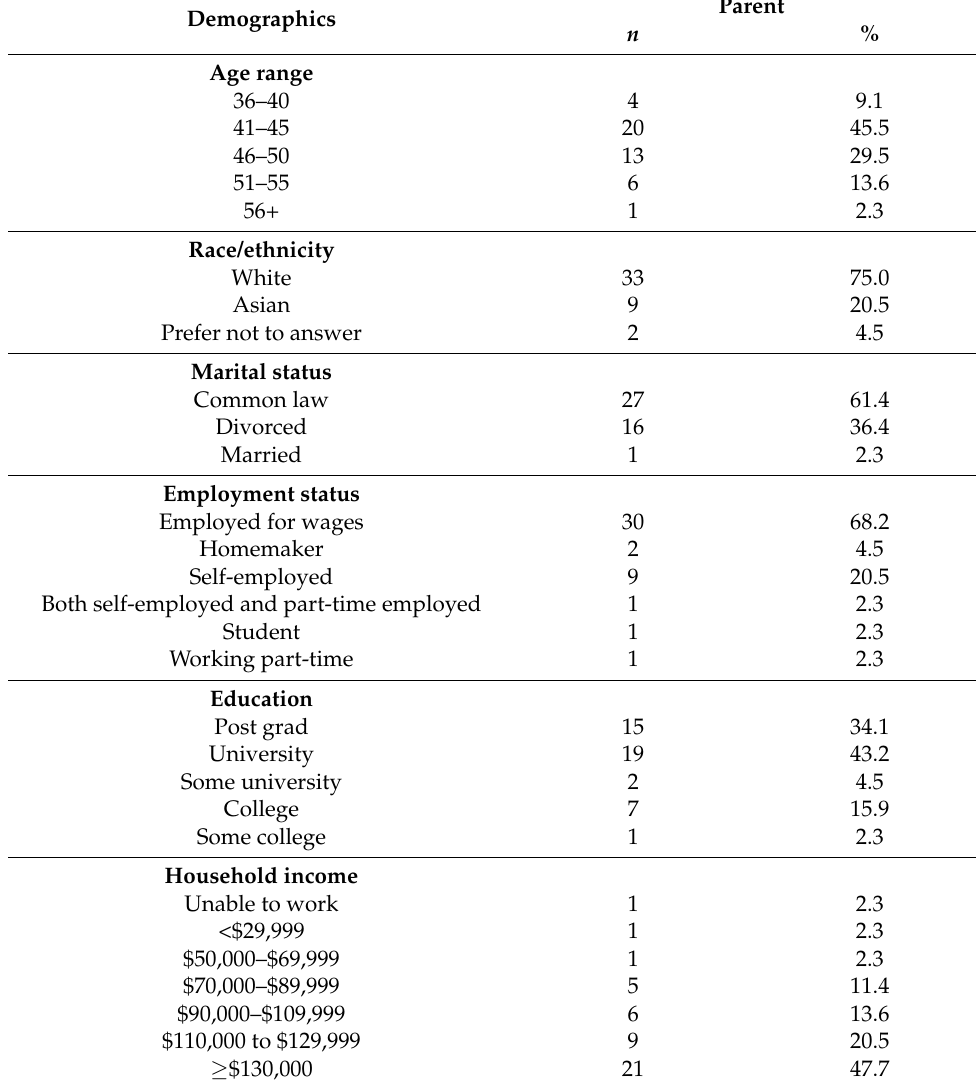
Table 1. Parental demographic